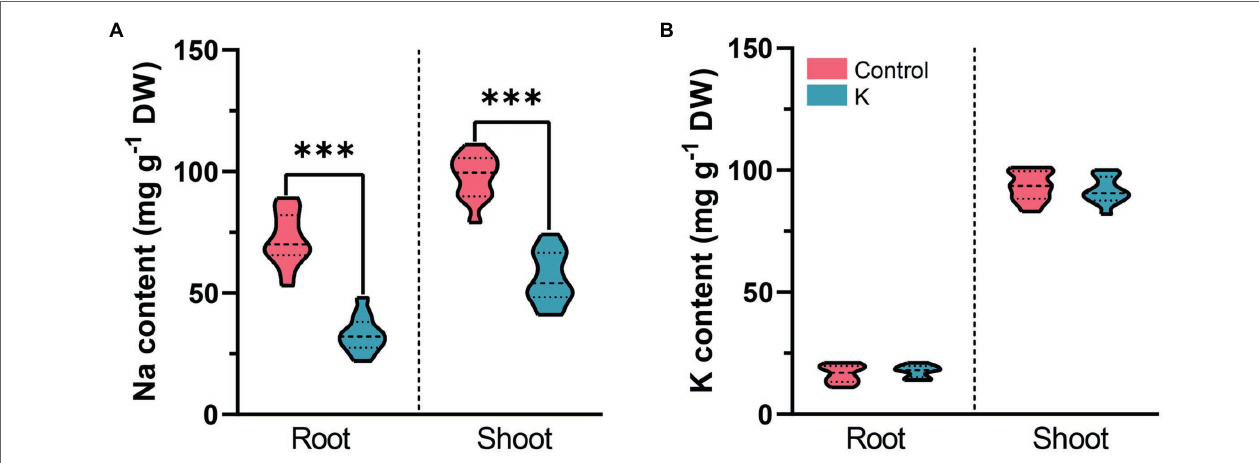
FIGURE 7 | Violin plot for levels of Na + and K + in shoots and roots of 21-day-old maize seedlings inoculated with Mucilaginibacter sp. K or not. Details as described in Figure 5 . (A) Strain K triggers reduction of Na + accumulation in shoots and roots compared with the control. (B) Strain K does not affect K + accumulation in maize seedlings. Asterisks indicate the statistically significant differences versus controls ( *** p < 0.001).